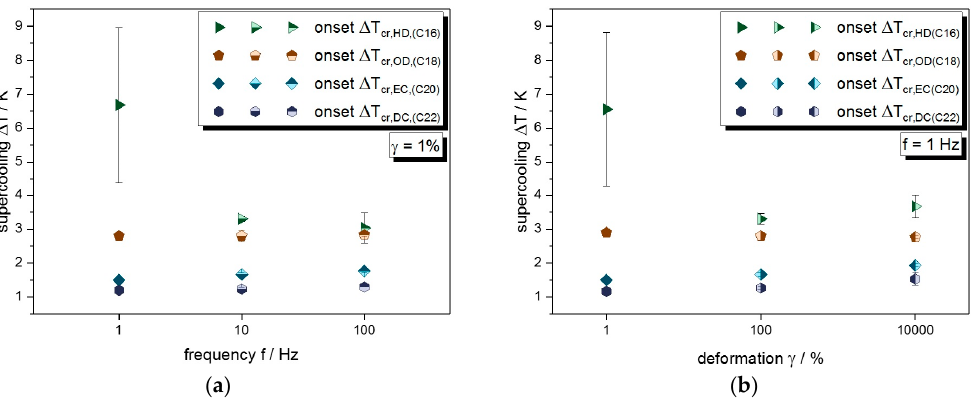
Figure 5. ( a ) Onset crystallization supercooling of 10 wt % alkane dispersions onset ∆ T cr , dispersion as a function of frequency f ; ( b ) Onset crystallization supercooling of 10 wt % alkane dispersions onset ∆ T cr , dispersion as a function of deformation γ